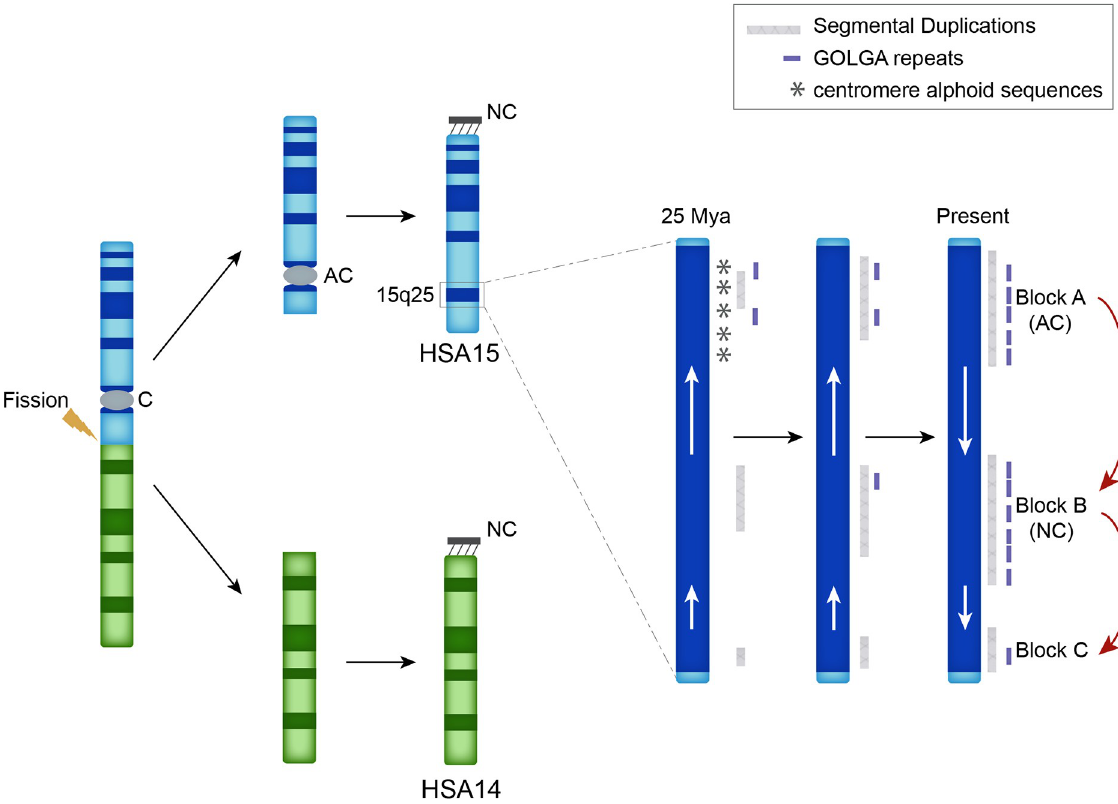
Fig 5. Human chromosome 15 evolution and GOLGA core elements dispersion. A fission event of an ancestral chromosome led to human and great ape chromosomes 14 (green ideogram) and 15 (blue ideogram). The zoomed-in view shows how the inactivation of the ancestral centromere after the fission event released the recombination constraints typical of pericentromeric regions leading to two inversions, shown with the white arrows, which resulted in a dispersal of GOLGA repeats (purple blocks) and segmental duplications (gray bars). AC, ancestral centromere. NC,